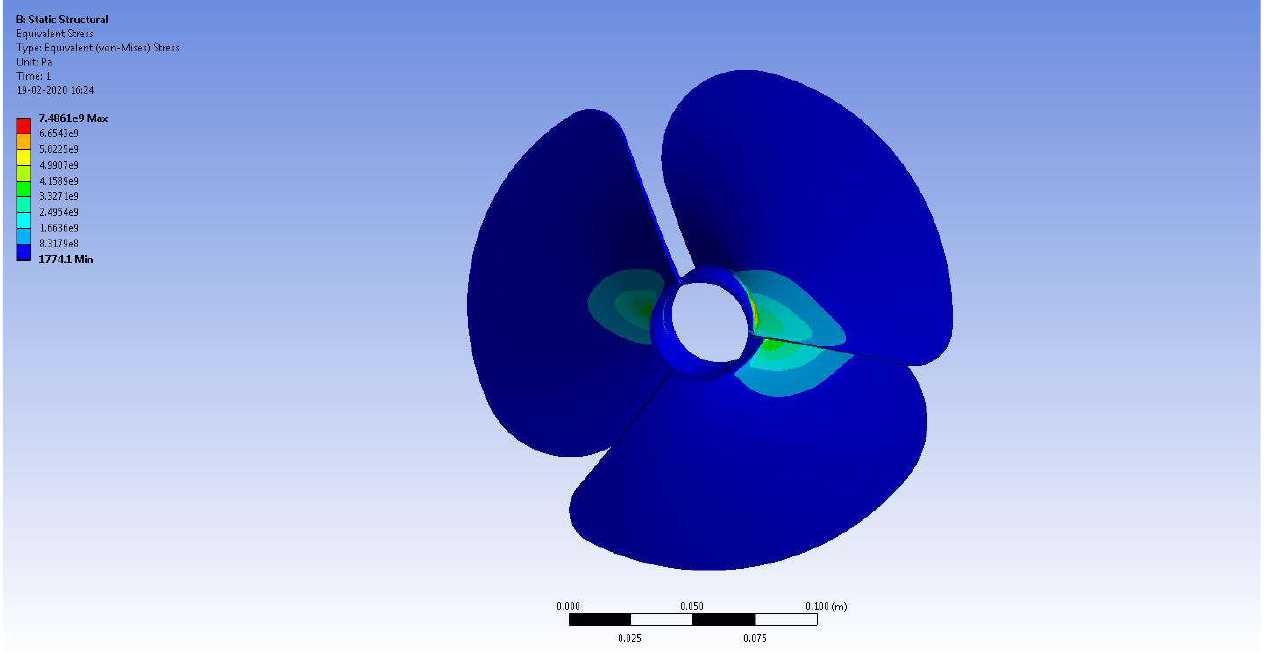
Figure 23. Normal Stress variation at 300 m depth with 20 m/s fluid velocity-CFRP-Prepreg-Wn-230-GPa.